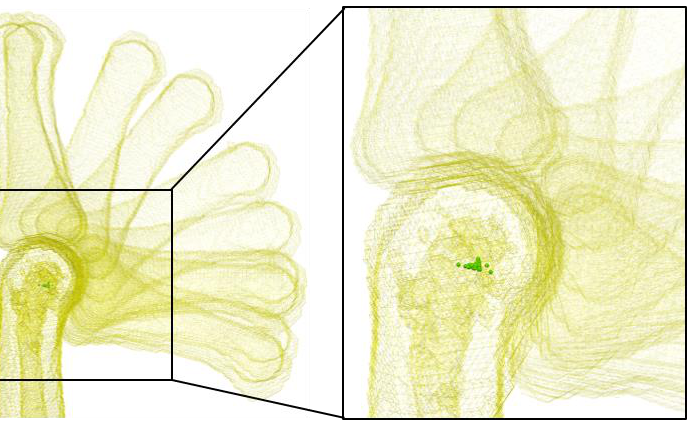
Figure 6. Variation of finite joint centers ( green ) with the change of flexion – extension of a hand